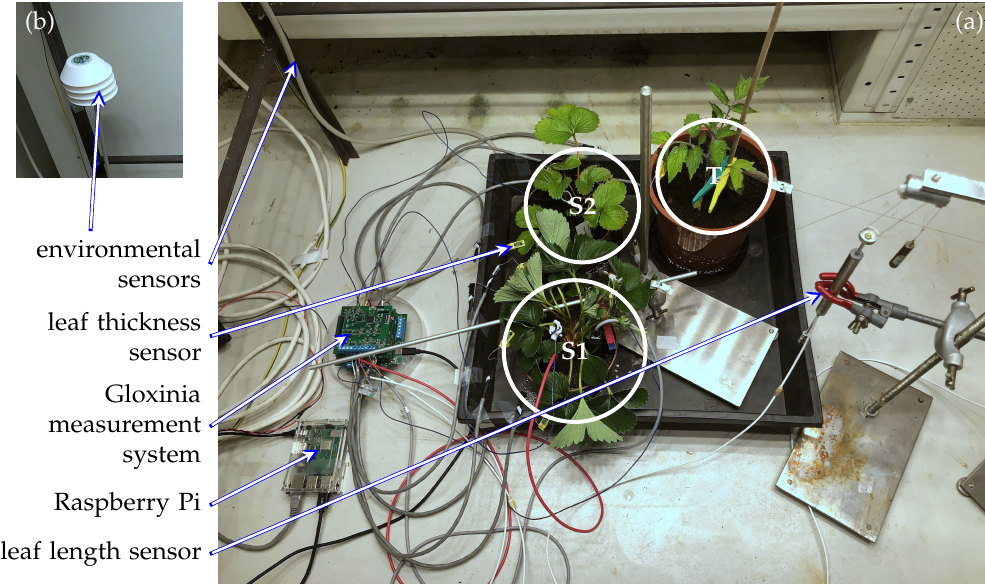
Figure 6. ( a ) Experimental set-up. The environmental sensors are not depicted in this figure, but their cable is. ( b ) Close-up of the radiation shield that houses the environmental